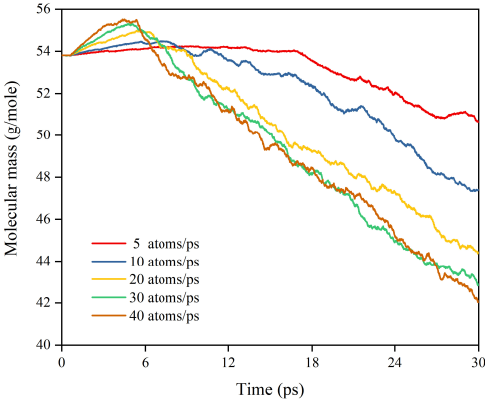
Figure 24. Mass changes of the Kapton during atomic oxygen impact at different dose rates.